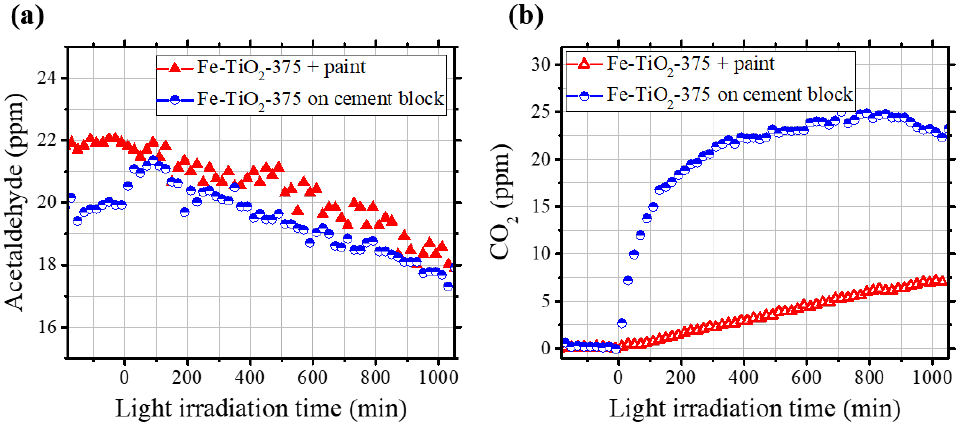
Figure 8. The results of the photocatalysis experiments (Fe-TiO 2 -375 mixed with paint or adhesive materials). Concentration changes of ( a ) acetaldehyde and ( b ) CO 2 as a function of the visible light irradiation time in the presence of Fe-TiO 2 -375 mixed with paint or a surface hardening agent and spread on a stainless steel surface or on a cement block, respectively.